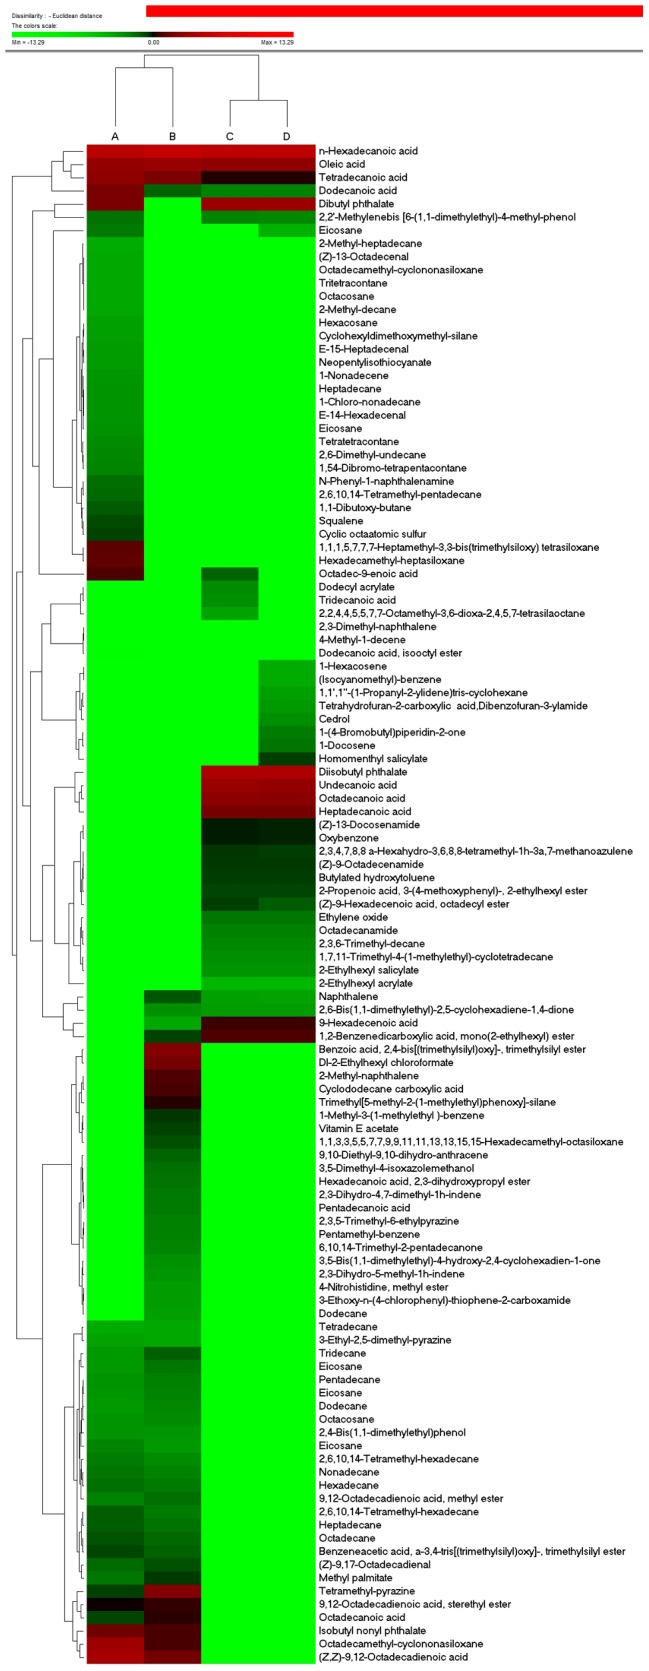
Hierarchical cluster analysis of all the detected compounds of volatile oil in four kinds of materials.A, B, C and D represent the seeds, fruit, suspension cell and callus. Colors in the heatmap mean the fold change in according to the above, red and green represent the higher and lower levels, respectively.